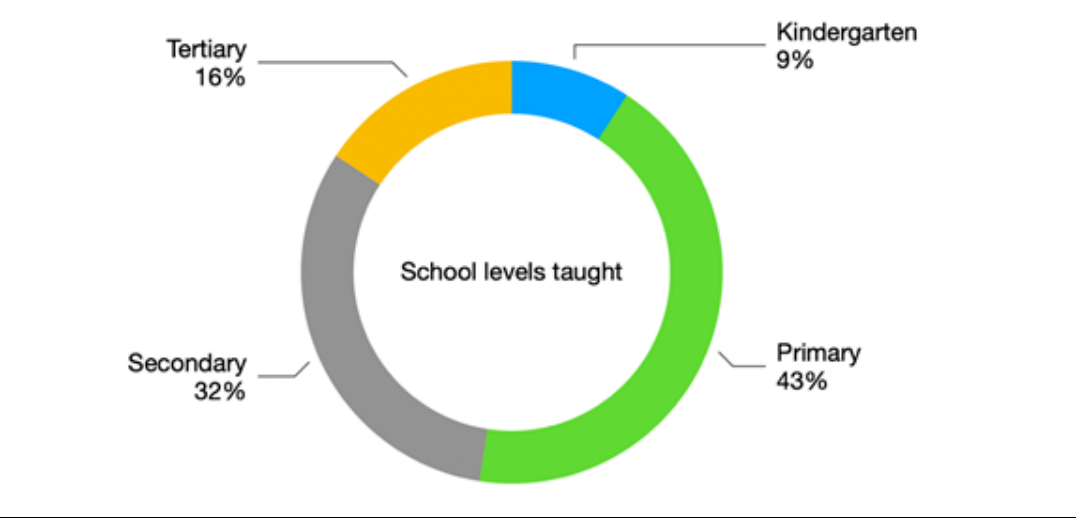
Figure 1. Levels taught by Teacher Survey participants (Source: Authors, 2022)